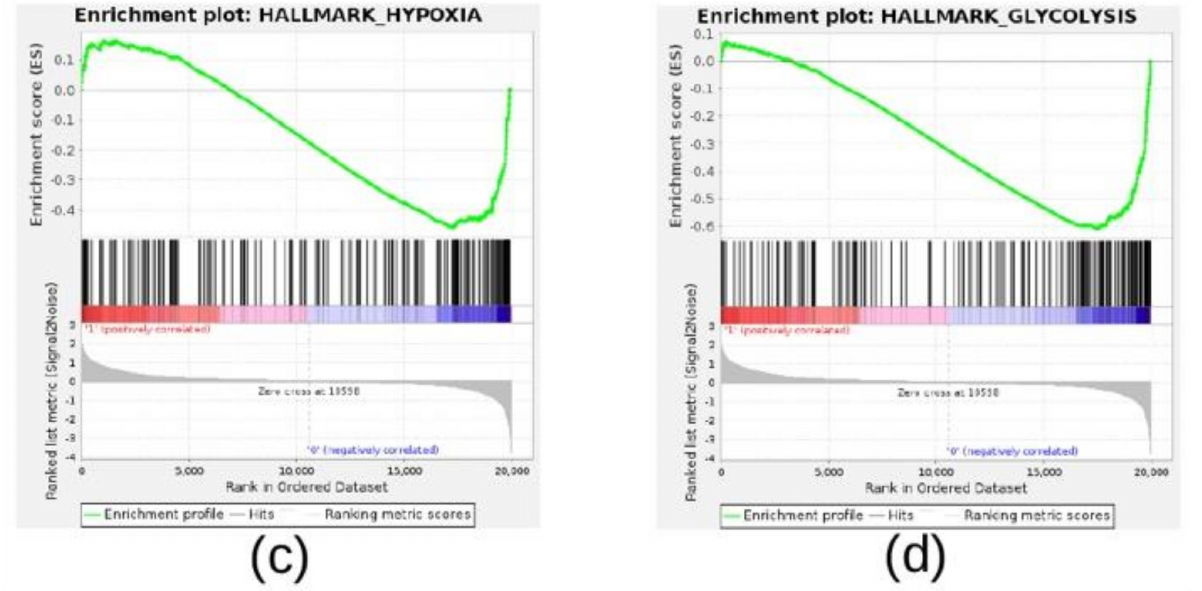
Figure 8. Enrichment plots for selected hallmark gene sets found negatively enriched in NB cells treated with mTORC complex inhibitor PP242. Selected enrichment plots from GSEA. The enrichment plot shows the gene set name (top), the running enrichment score (green curve), the positions of the gene set hits on the rank ordered list in GSEA (black bars), the rank ordered list according to the signal-to-noise metric (bottom). Red indicates the highest signal-to-noise values, whereas blue indicates the lowest ones. Plots are relative to: ( a ) HALLMARK_MTORC1_SIGNALING, ( b ) HALL- MARK_PI3K_AKT_MTOR_SIGNALING, ( c ) HALLMARK_HYPOXIA, and ( d )